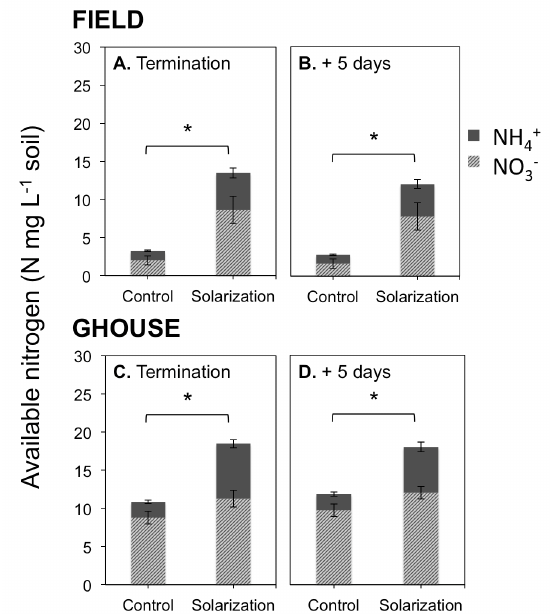
Figure 2. Mean ± SEM available nitrogen in the FIELD experiment (A) at plastic termination and (B) five days after termination, and in the GHOUSE experiment (C) at termi- nation and (D) five days after termination. Data are shown pooled across treatment durations. Asterisks (*) denote statistically significant treatment effects at α = 0.05.